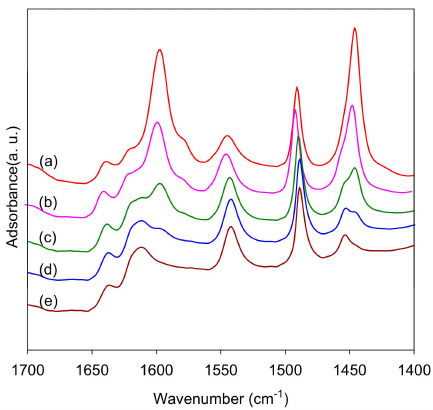
Figure 7. Fourier Transform Infrared (FT-IR) spectra of pyridine adsorbed over Pt / HZSM-48 catalyst under 10 − 3 torr at ( a ) 100 ◦ C, ( b ) 150 ◦ C, ( c ) 200 ◦ C, ( d ) 250 ◦ C, and ( e ) 300 ◦